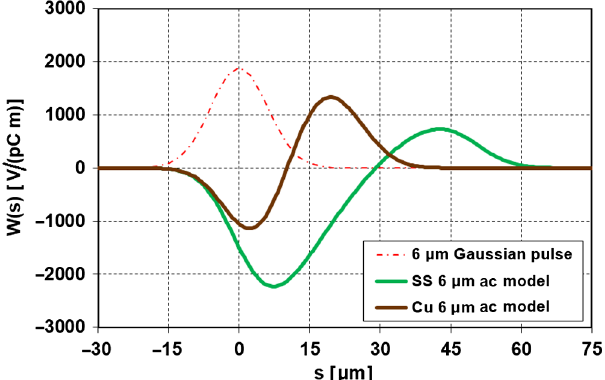
FIG. 17. Longitudinal wakefields for the 8.2-mm diameter hole for stainless steel and copper and the corresponding Gaussian test pulse. The lower loss with copper gave the incentive to add copper